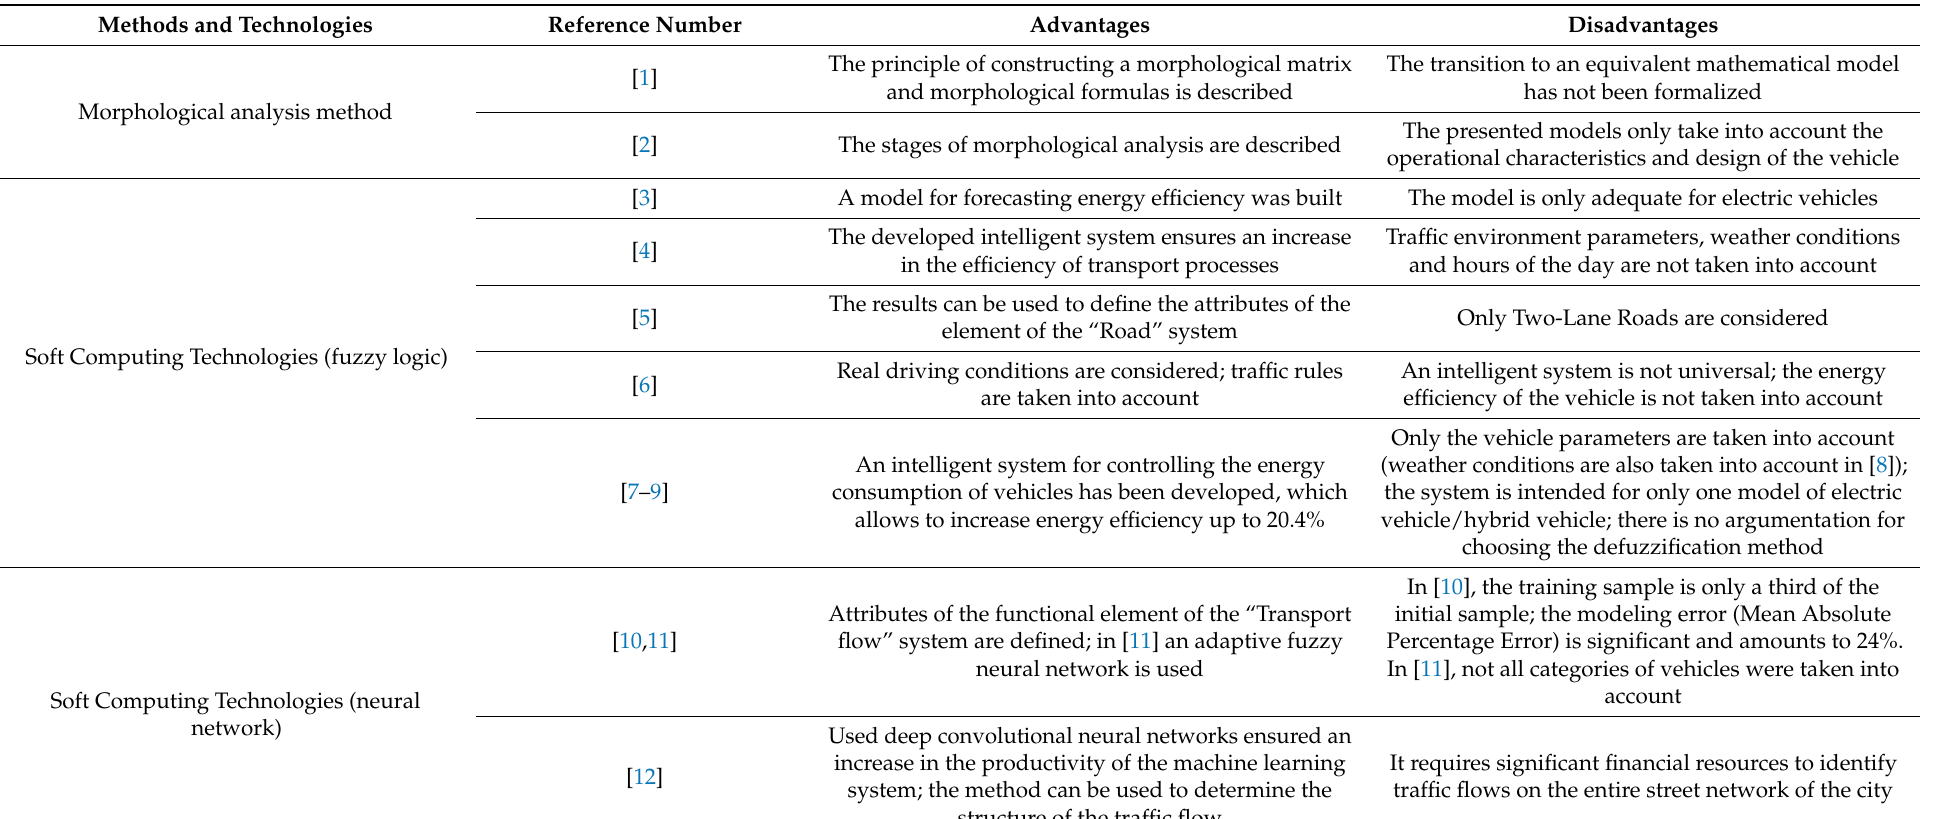
Table 1. Generalized characteristics of the results of recent